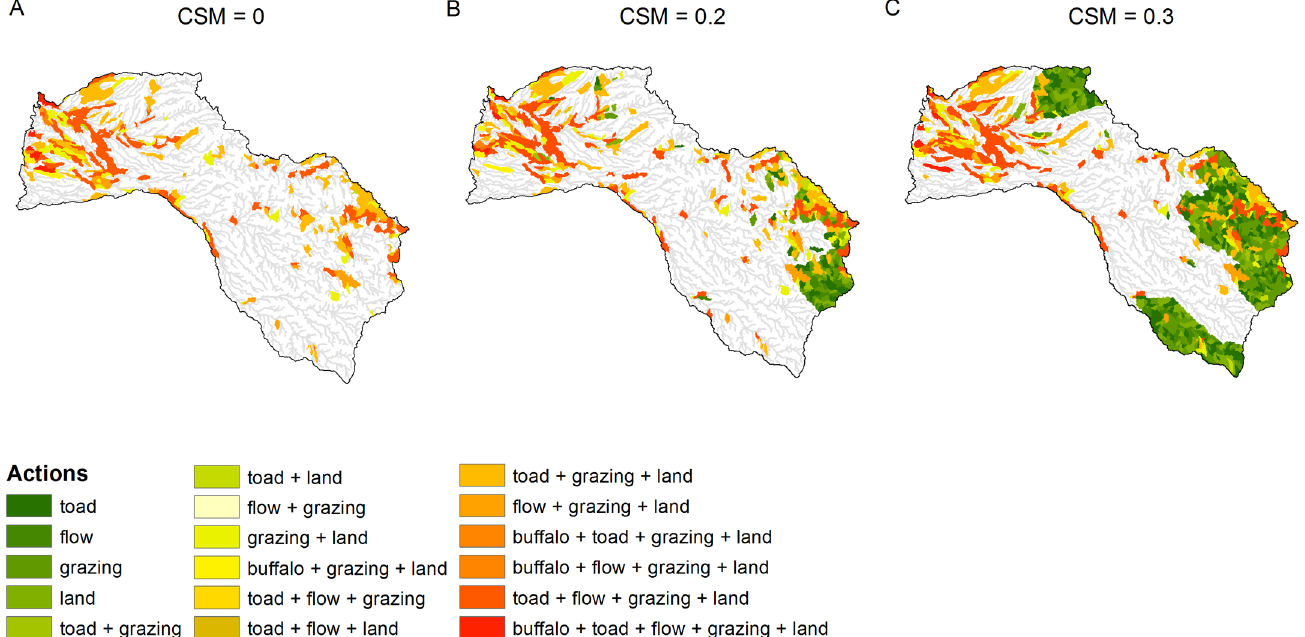
Fig 3. Spatial distribution of the actions selected by the action prioritization algorithm. Results are shown for increasing values of the Connectivity Strength Modifier ( CSM